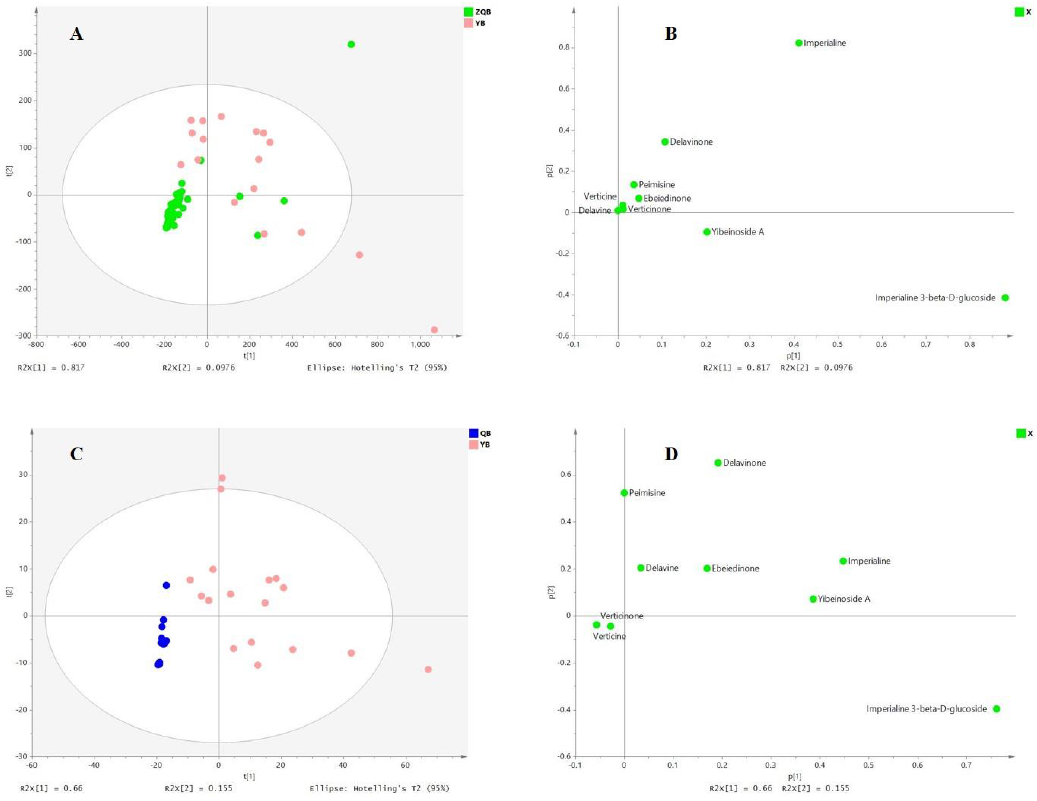
Figure 4. The PCA of bulbus of FCB and FPB based on the content of nine alkaloids: score plot ( A , C ) and loading plot ( B , D ). and loading plot ( B , D